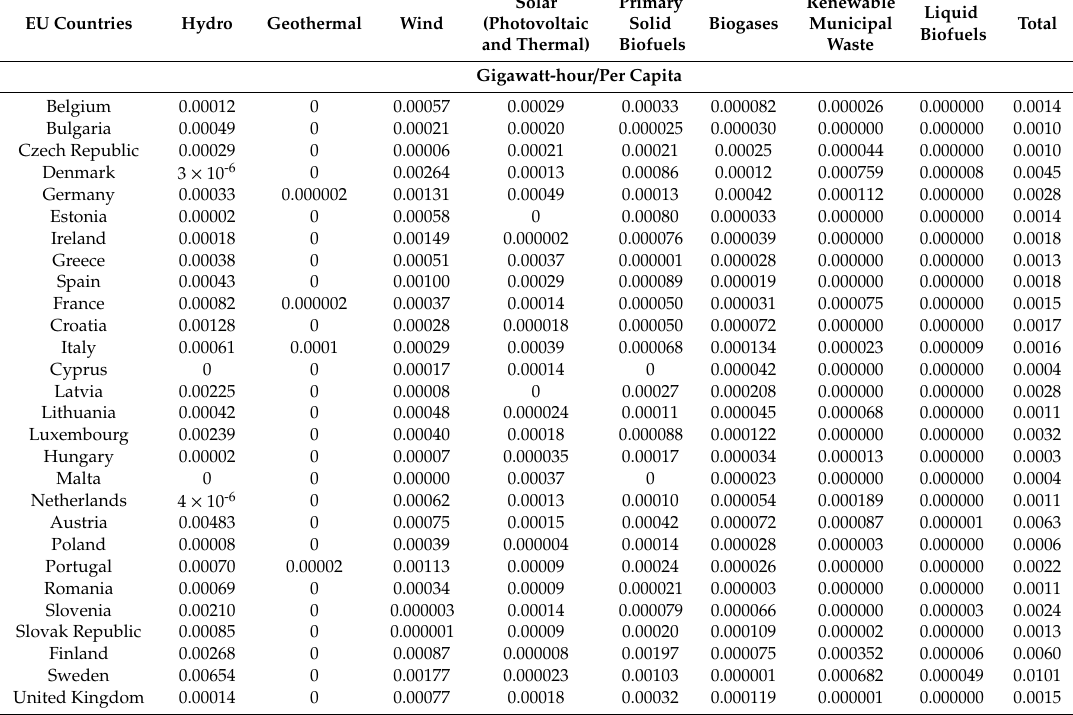
Table 3. Structure of energy production from renewable energy sources per capita of individual EU countries in 2017 (own study based on data from